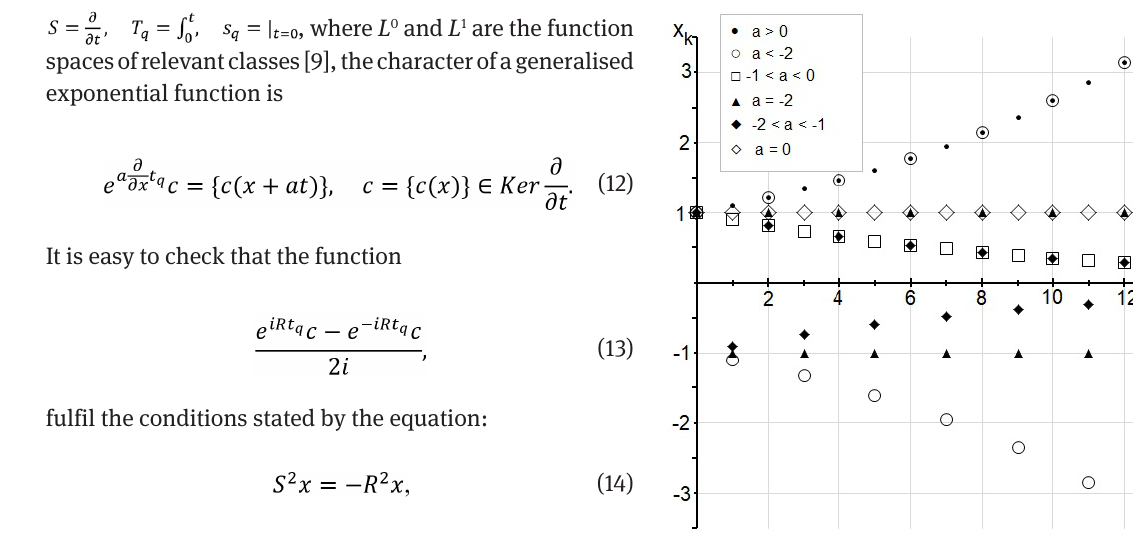
}={1} and different 0